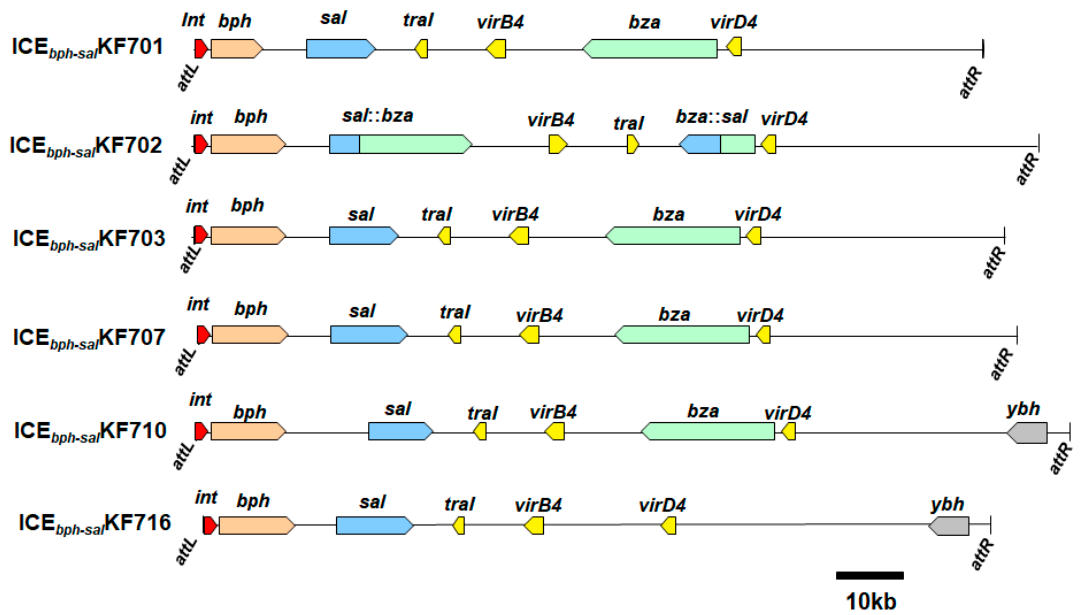
Figure 3. Organization of the ICE bph-sal s [7]. Genes on each arrow encode: attL and attR , ICE integration sites; int , integrase; bph , proteins involved in biphenyl catabolism; sal , proteins involved in salycilate catabolism ; traI , relaxase (MOB); virB4 , TSS4 component VirB4; bza , proteins involved in benzoate catabolism; virD4 , TSS4 component VirD4; and ybh , YbhFSR ABC-type